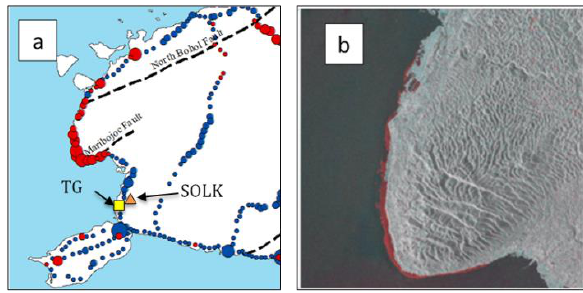
Figure 9. Land uplift (red) and land subsidence (Blue/Cyan) from geodetic levelling and RADARSAT SAR interferometry